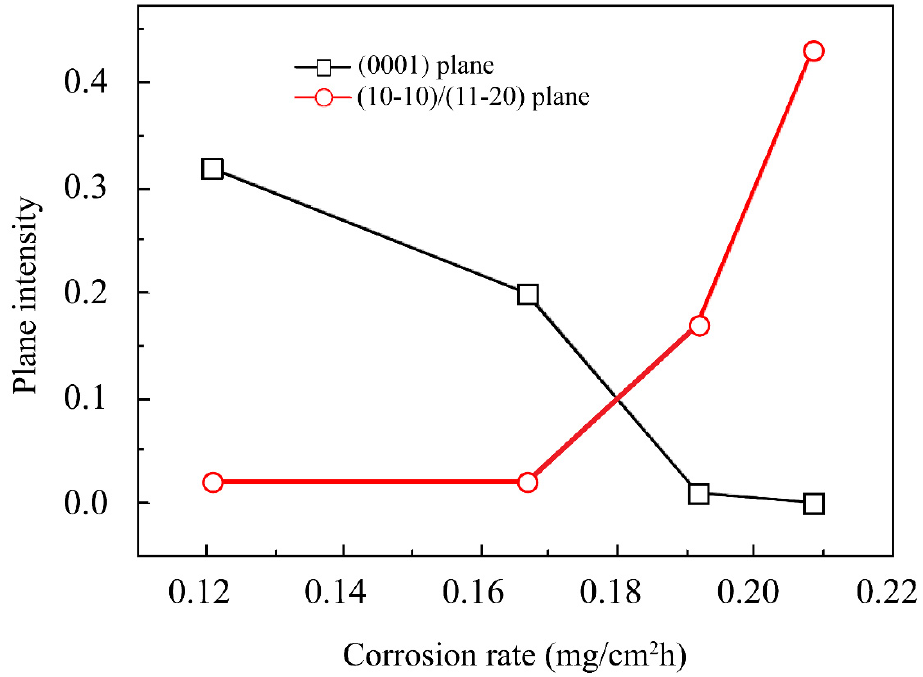
Figure 5. Correlation between the corrosion rate and intensity planes in an AZ31 Mg alloy in 3.5 wt% NaCl